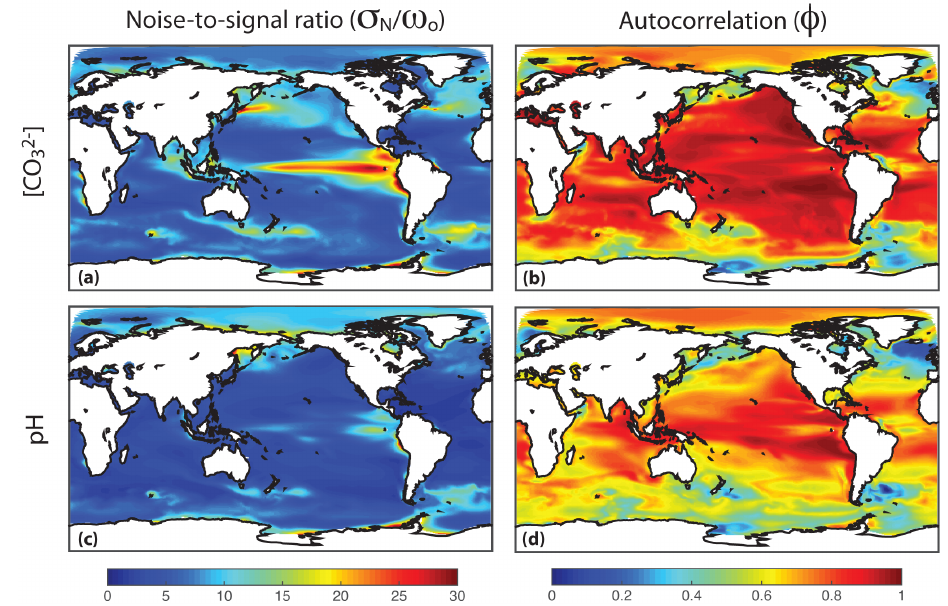
Figure 6. (1st column) The noise-to-signal ratio ( σ N /ω 0 , years) and (2nd column) lag-1 autocorrelation in monthly, de-seasonalized surface ocean (1st row) [CO 2 − ], and (2nd row) pH 3